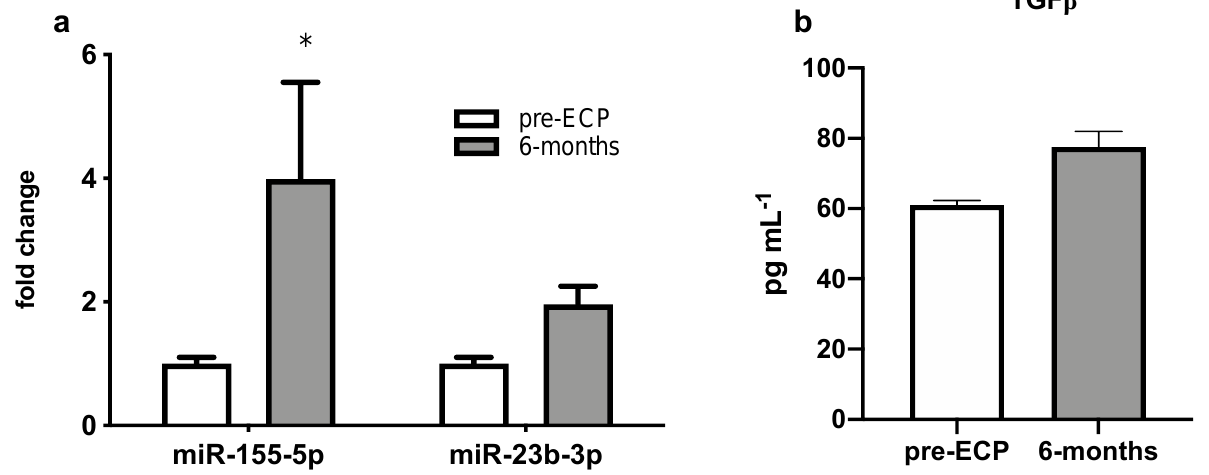
Figure 5. ( a ) Quantitative expression of miR-155 and miR-23b assessed by qRT-PCR and ( b ) TGF β